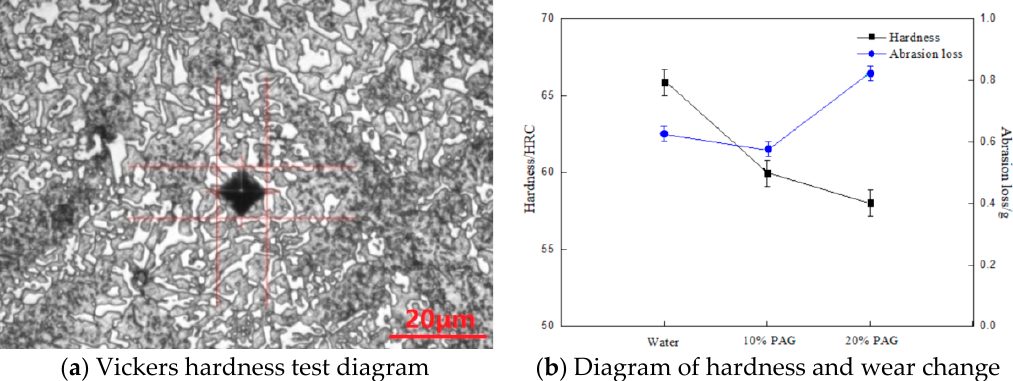
Figure 4. Relationship between hardness and abrasion loss of high chromium cast iron with different quenching mediums. Table 6. The HV0.1 of the eutectic carbide of high chromium cast. Quenching